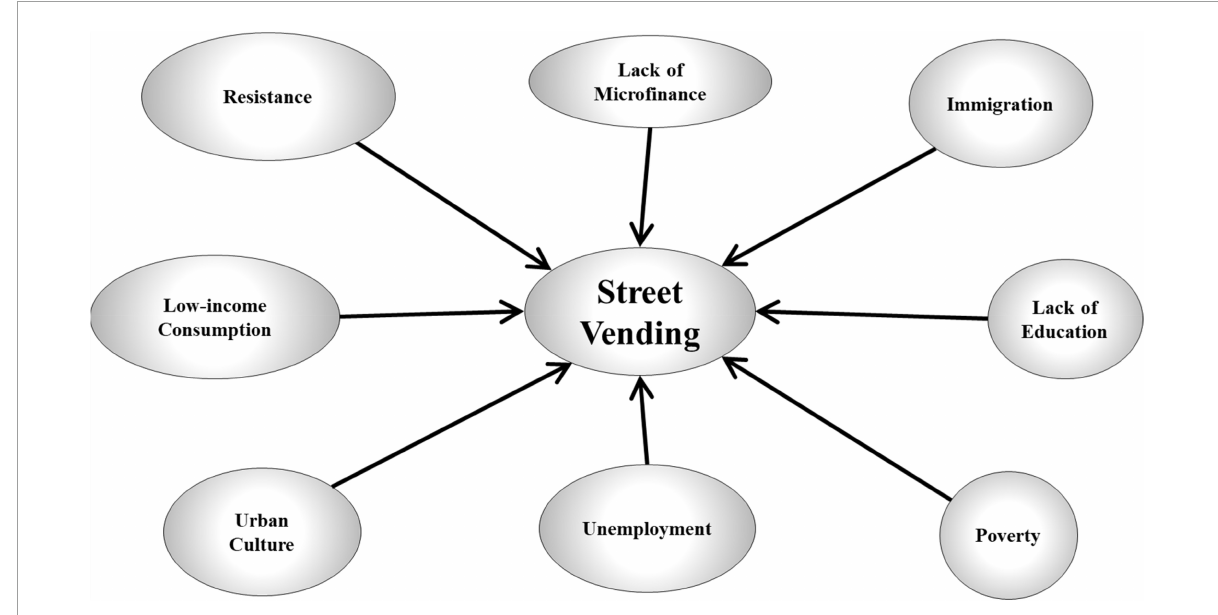
FIGURE1 Conceptual model of street